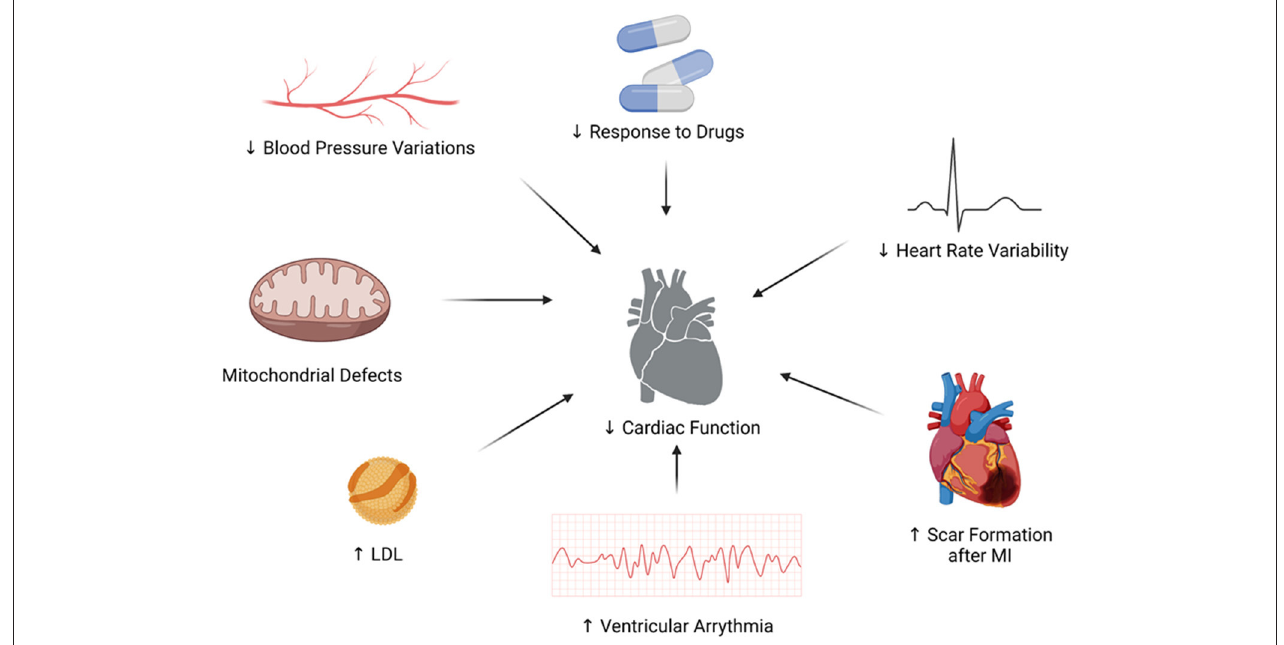
FIGURE 1 | The interfaces between the circadian rhythm and the autonomic nervous system, contributing to the pathogenesis of congestive heart